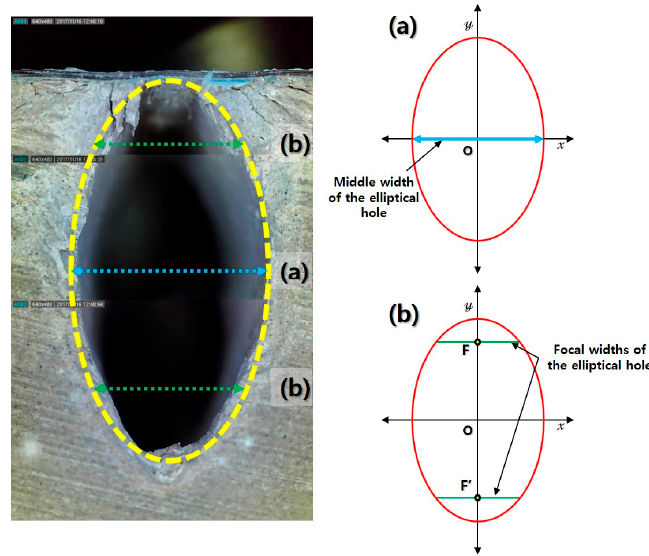
Figure 11. Measurement positions on ( a ) the middle width and ( b ) the focal widths of the elliptical hole.